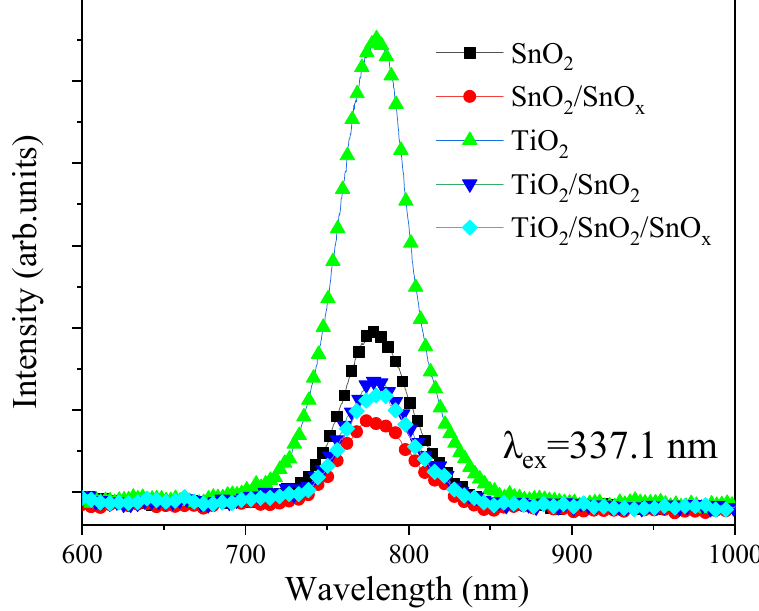
Figure 3. Photoluminescence spectra of the perovskite films prepared with the different conditions of ETL (excitation wavelength = 337.1 nm).